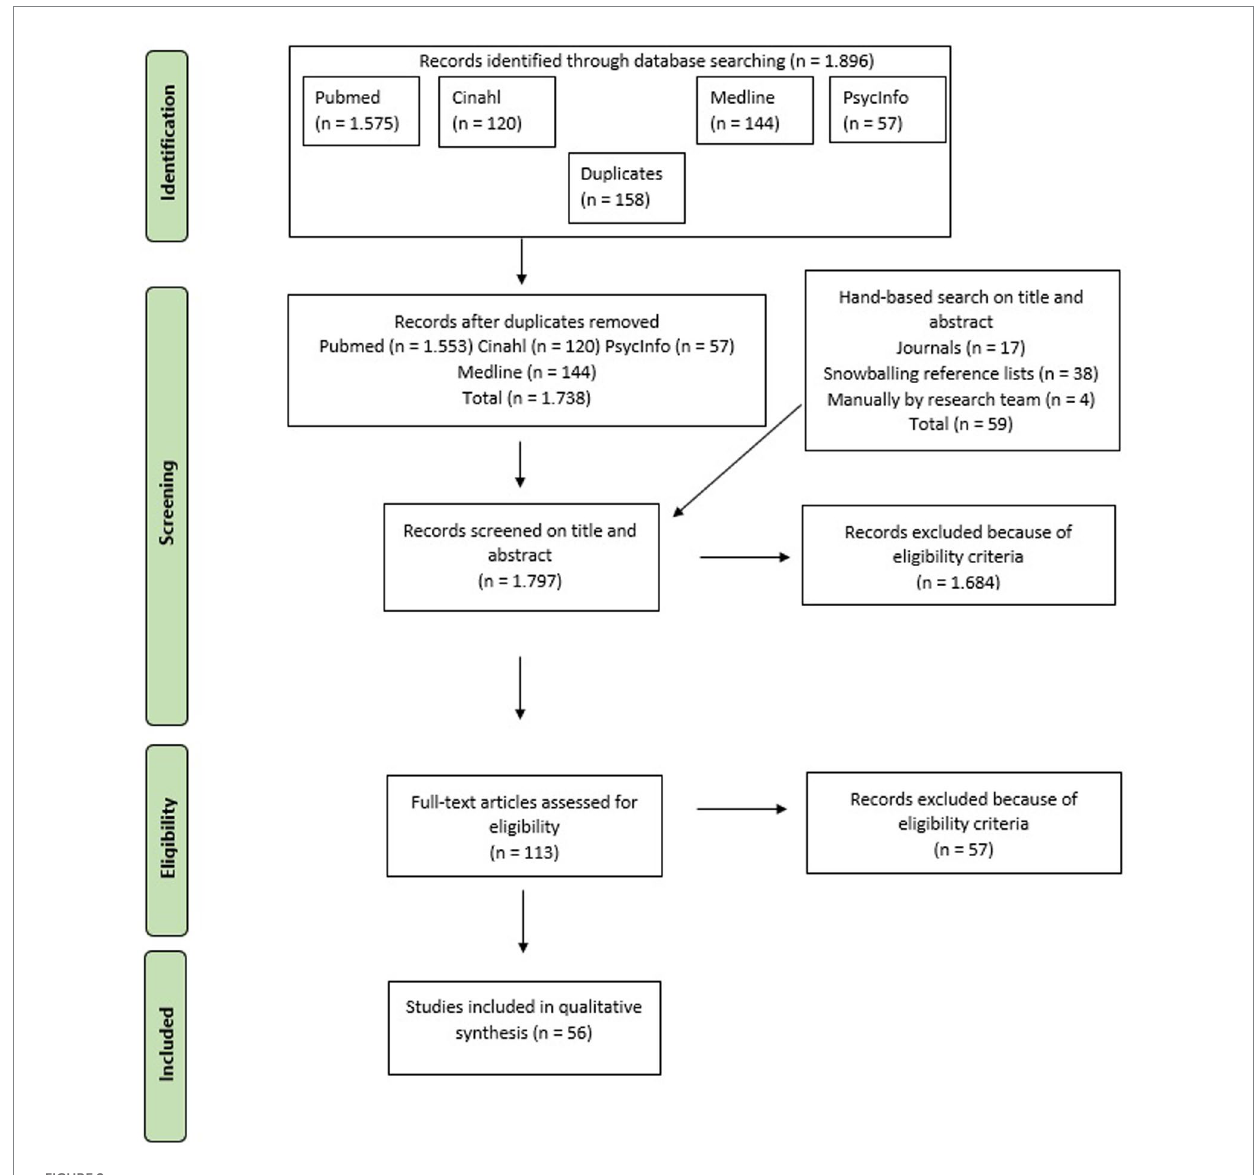
FIGURE 2 PRISMA